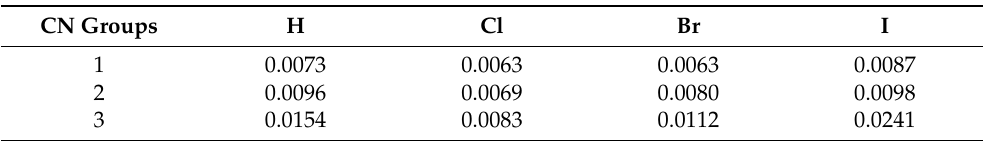
Table 9. Changes in electron density at C-X . . . N bond critical points (a.u.) per number of CN